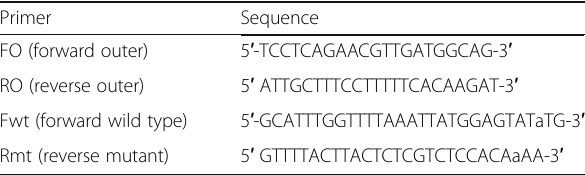
Table 2 Primers sequences for JAK2 p.V617F mutation detection by ARMS